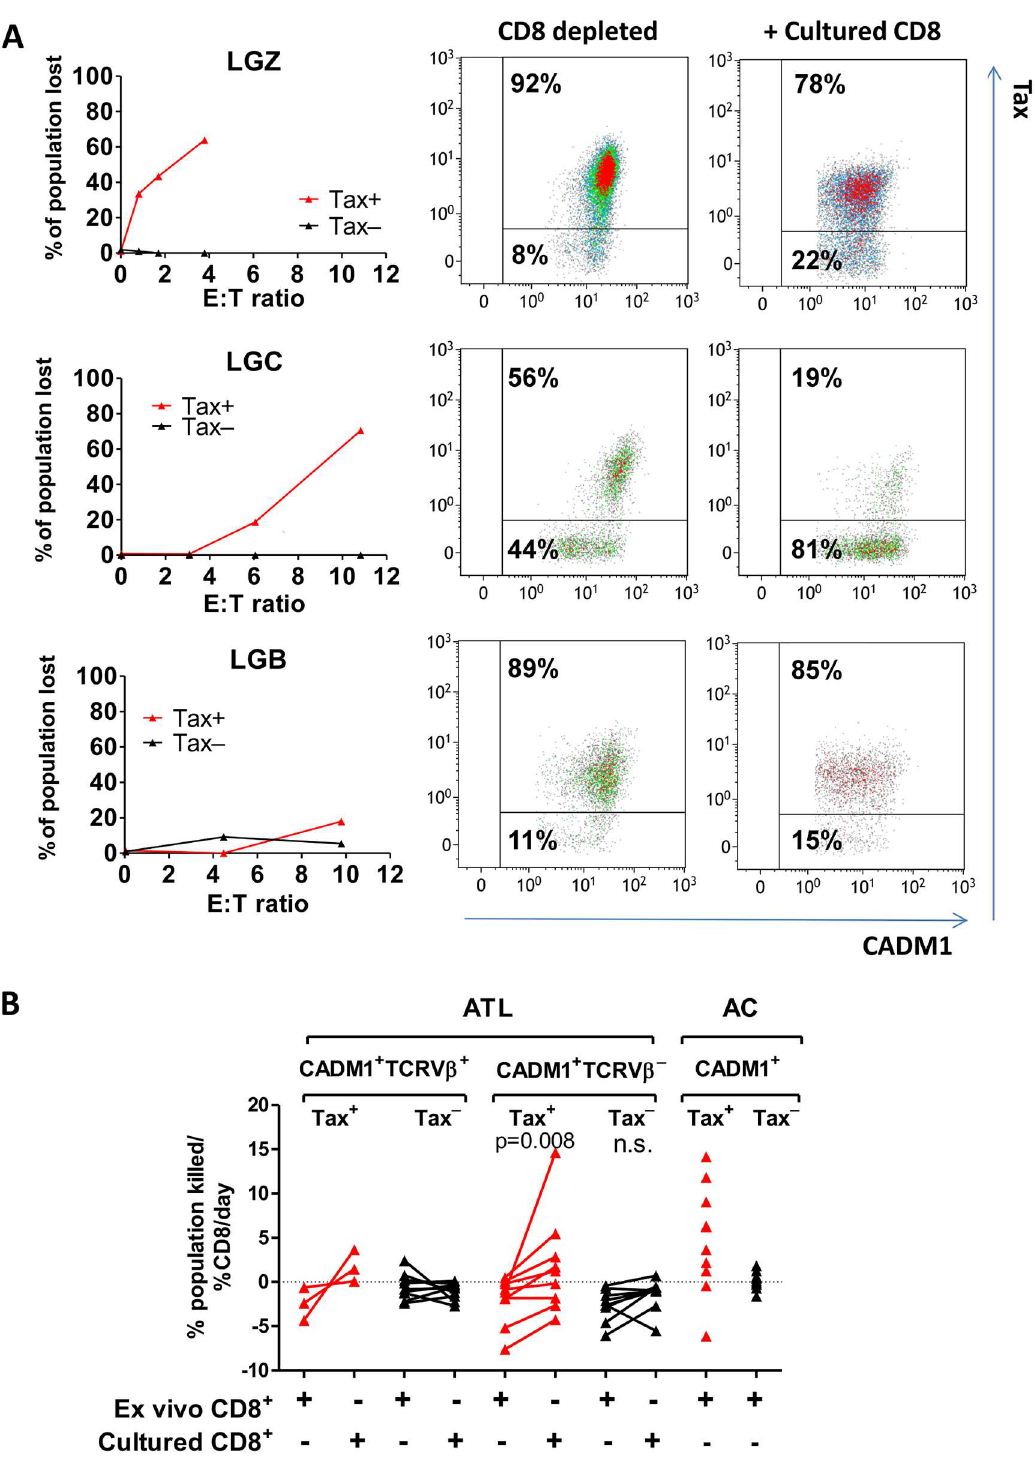
Fig 7. Tax-expressing cells are preferentially killed by cultured autologous CD8 + cells. (A) Selectiveloss of live Tax-expressing ATL cells after incubation with cultured CD8 + cells. Extendedanalysisof data from Fig 6. ATL clones from three Tax high ATL patients (LGZ, LGC and LGB) were gated on the basis of Tax expressionas shown. For each donor, graphs show the percentage of Tax + or Tax − cells which were killedin the presence of cultured autologousCD8 + cells. Flow plots show Tax and CADM1 expressionby live CD3 + CD4 + CADM1 + TCRV β X + cells from each